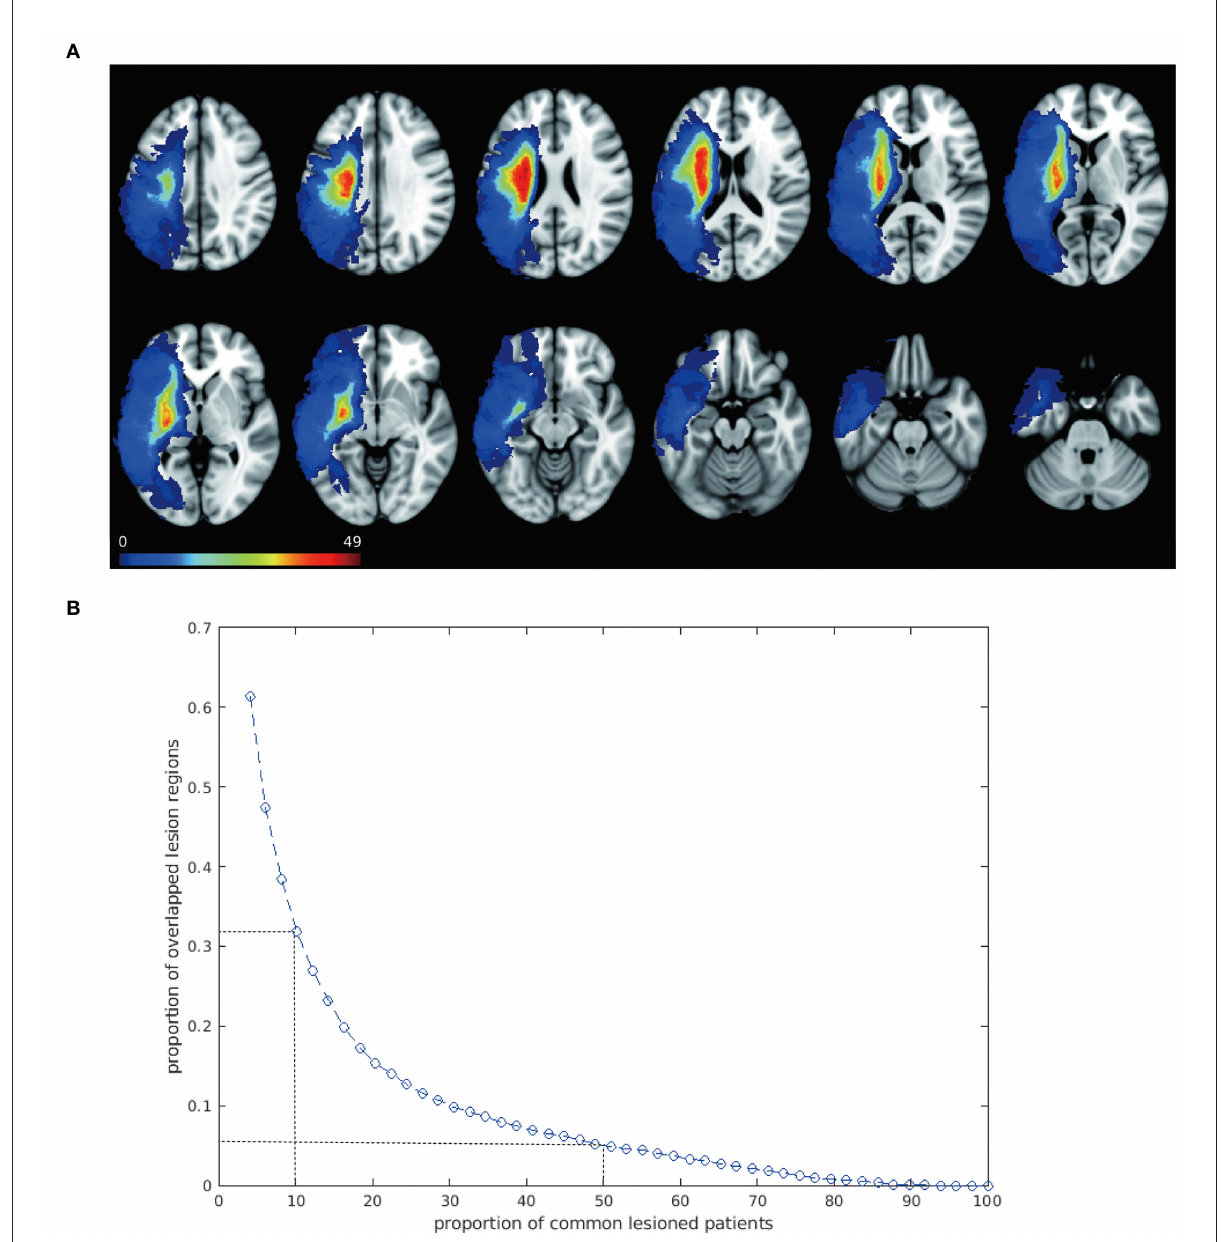
FIGURE1 Overlapped lesion mapping shows large spatial variability. (A) Overlapped lesion mapping. Overlay of lesions of 49 patients with post-stroke aphasia is shown. Lesions spread to a large area of the left hemisphere and are mostly distributed in the blood supply area of the left hemisphere middle cerebral artery. Color scale illustrates the number of patients with a lesion in that voxel, with warmer color indicating higher number. (B) Overlap of the lesion regions across people. The blue curve shows a trend of decreasing proportion of overlapped lesion regions along with increase in patients, indicating great inter-subject variability of the lesion location. Two dots with dash lines are shown as examples: about 30% of the lesioned regions are shared by approximately 5 patients (10%); when the proportion of patients was raised to 50%, only 5% of the lesioned regions were commonly